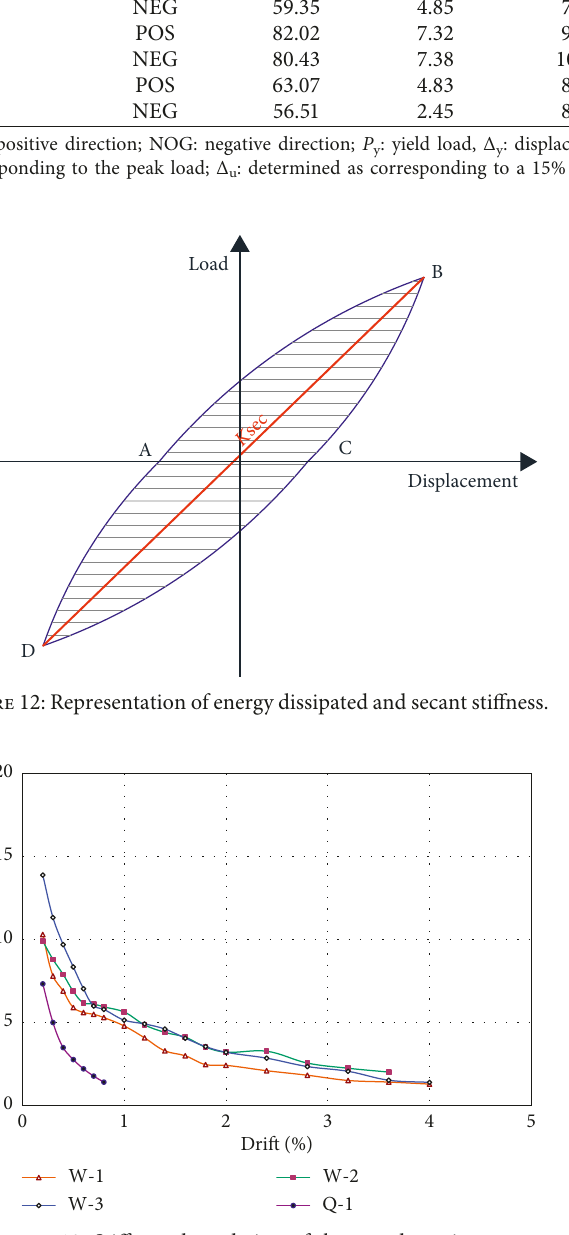
Figure 13: Stiffness degradation of the tested specimens.